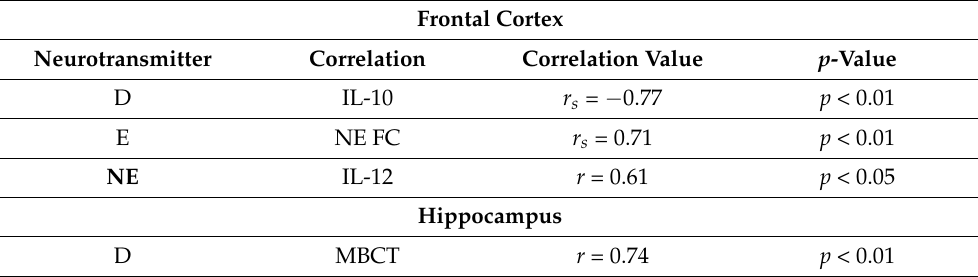
Table 2. Correlative analyses among parametrized variables in infected mice at day 14-PI.